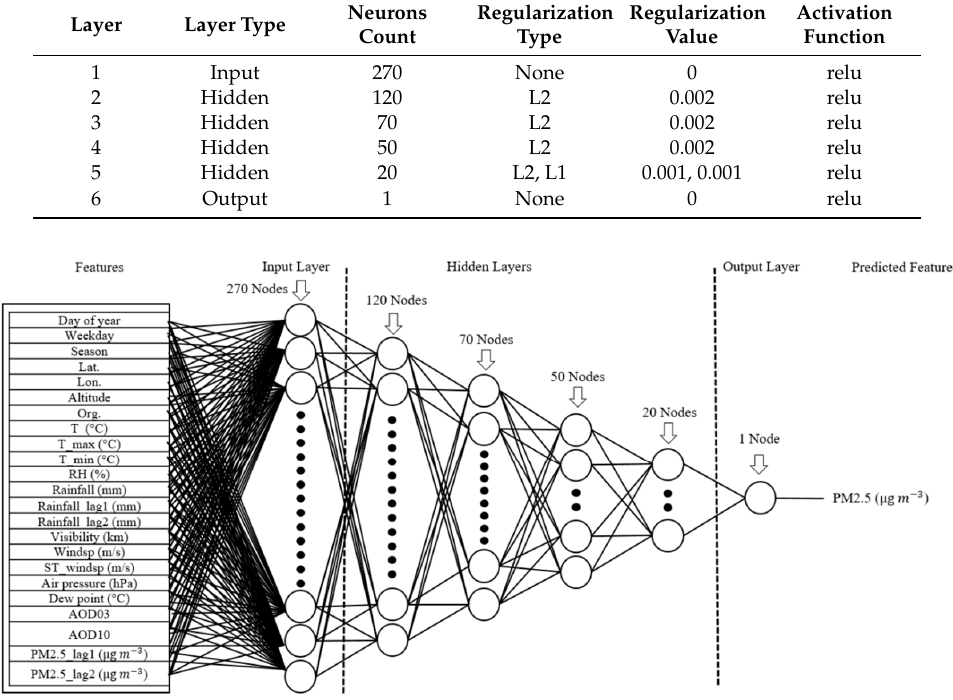
Figure 2. The deep neural network configuration with six layers (4 hidden layers) employed in this study to predict PM 2.5 concentration value.